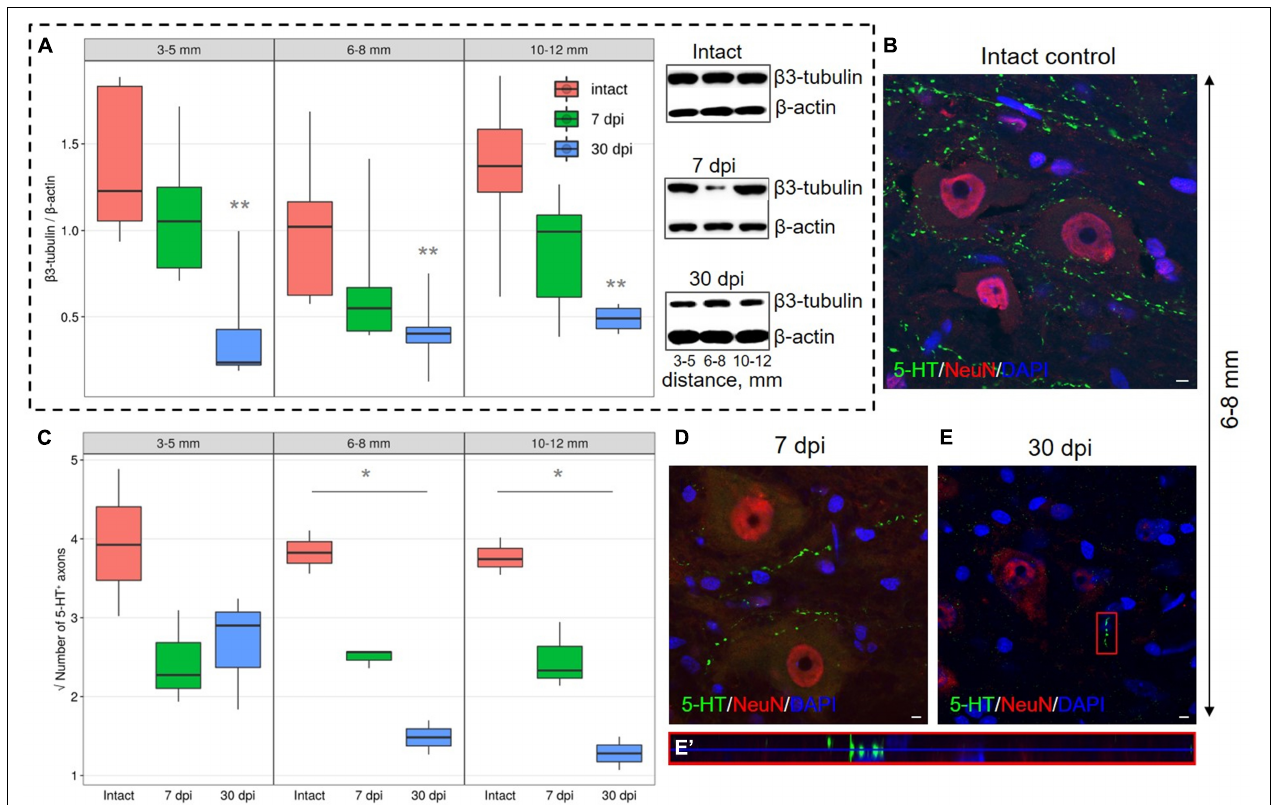
FIGURE 4 | Estimation of axon-associated proteins in the ventral horns (VH) with increasing distance from the injury site in the caudal direction. (A) Western blot analysis of β 3-tubulin, β -actin was used as a loading control. Data are presented as the ratio of the quantity of target protein ( β 3-tubulin) to the reference protein ( β -actin), the average value ( n = 5 rats per group). ** P < 0.05 – compared with the intact group at an appropriate distance from the epicenter, Mann–Whitney U test. Visualization of 5-HT + axons in the intact spinal cord (B) , 7 (D) , and 30 (E) dpi in VH 6–8 mm caudally from the injury epicenter. 5-HT + axons at 30 dpi are marked with red boxed area and are shown enlarged in another X, Y, and Z positions in (E (cid:48) ) . Three-dimensional confocal microscopy images are shown. Nuclei were counterstained with 4 (cid:48) ,6-diamidino-2-phenylindole (DAPI). (C) Square root of 5-HT + axons ( Y -axis) number in the intact spinal cord (red column), 7 (green